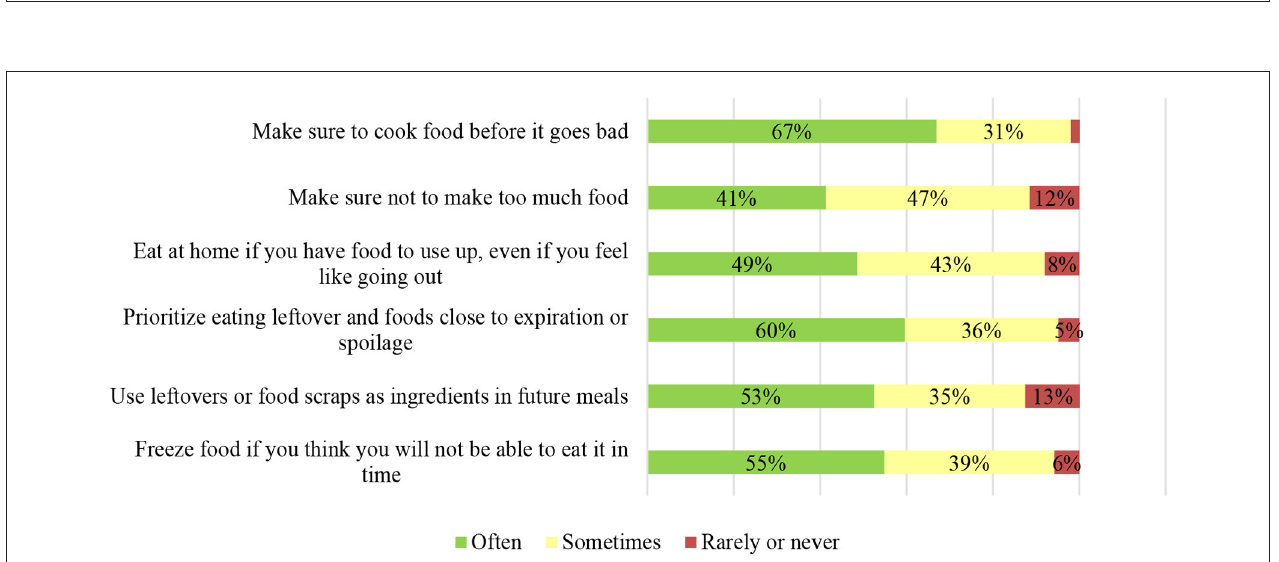
FIGURE 4 | Participant engagement in household food waste reduction strategies. Participants were asked to report how often they engage in six household food waste reduction strategies/practices (values < 5% not labeled in figure).